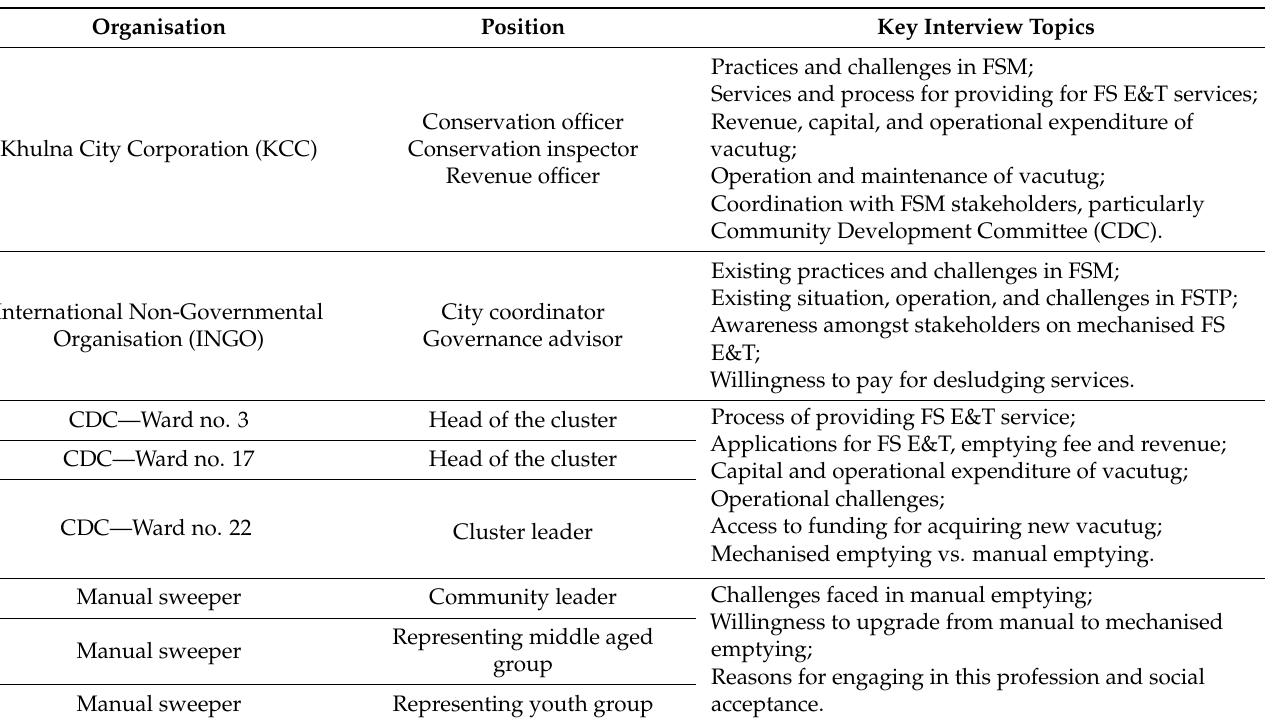
Table 1. List of interviews and key interview